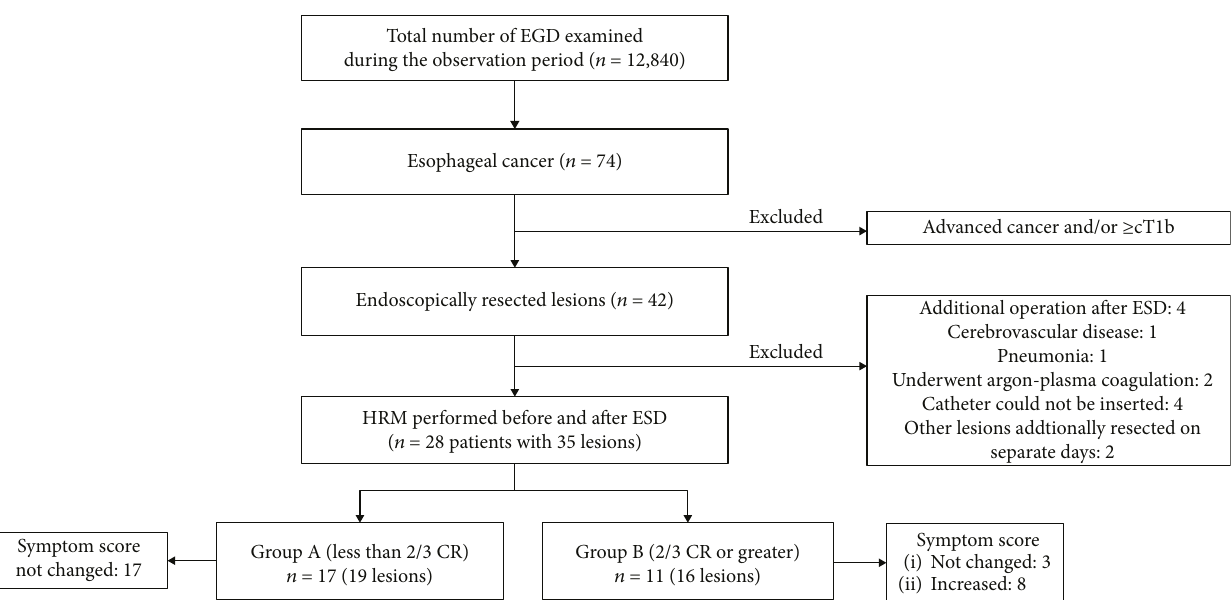
Figure 4: Study outline. Of 42 enrolled patients, 28 patients with 35 lesions were analyzed (group A: n = 17 , group B: n = 11 ). Eight patients had a post-ESD increase in symptom score; all of these patients were in group B. ESD: esophageal submucosal dissection, cT1b: clinical T1b, HRM: high-resolution manometry, CR: circumferential Table 1: Baseline characteristics of patients with early esophageal cancers.